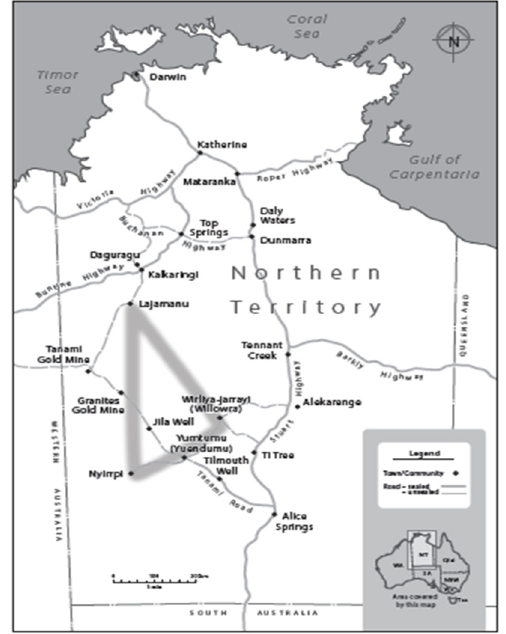
Figure 1. Map of the NT showing the Warlpiri Triangle communities (by Brenda Thornley (O’Shannessy et al. 2019). Used with permission).